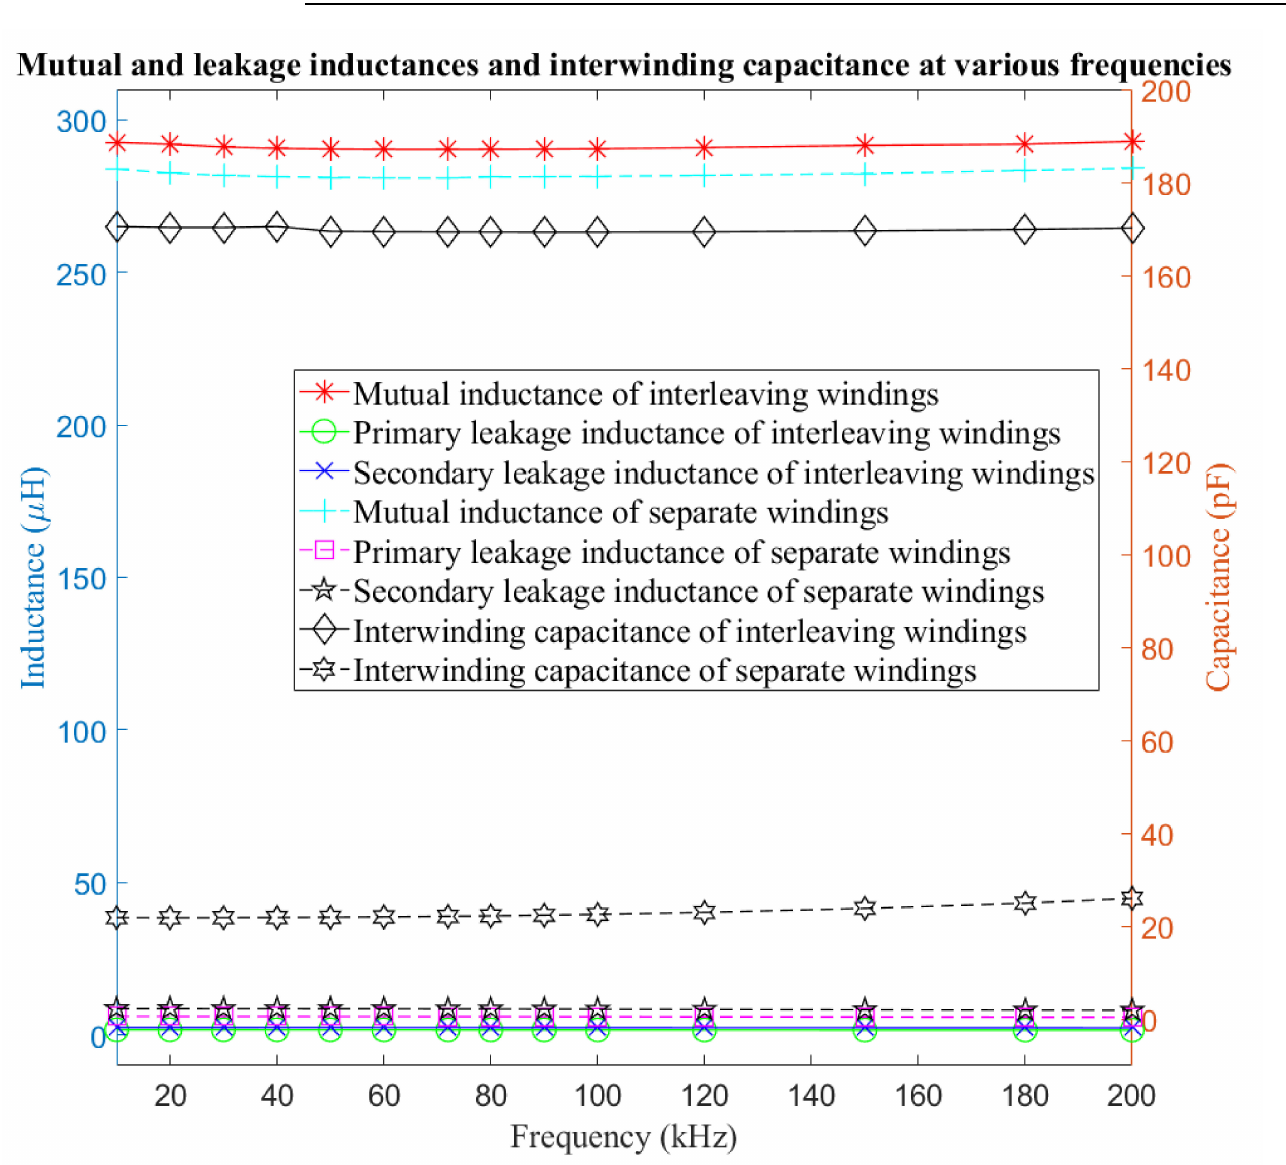
Figure 18. Circuit inductances and interwinding capacitances of separate and interleaved winding structures from 10 to 200